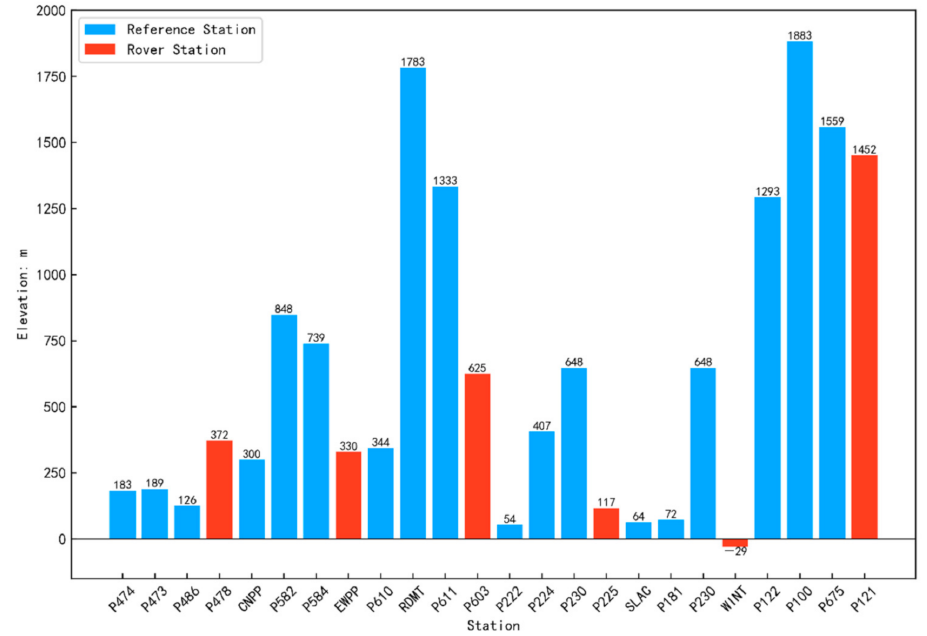
Figure 3. The elevation distribution of the stations in Dataset One.